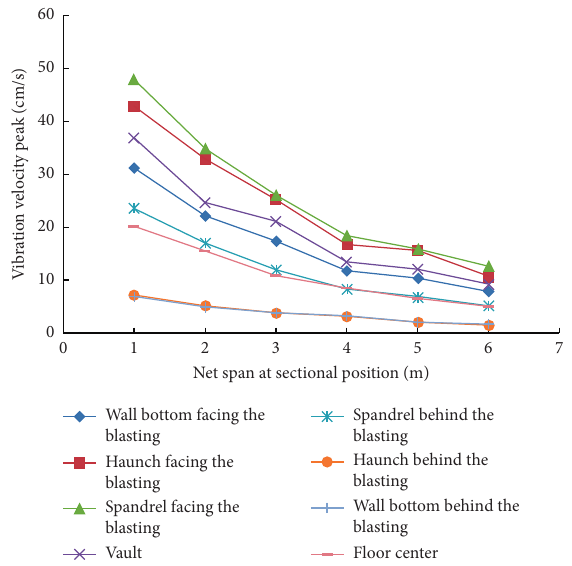
Figure 10: Variation curves of vibration velocity peak with net span at sectional positions.